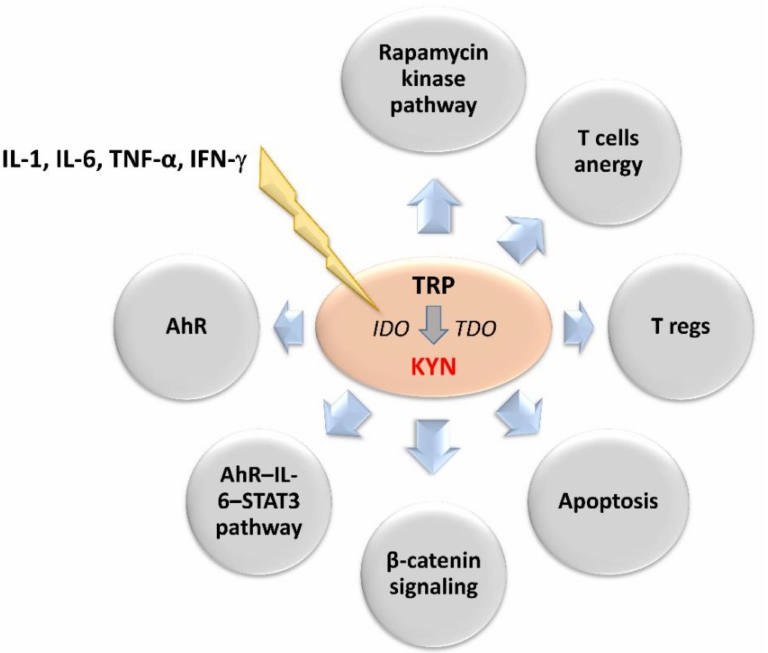
Figure 2. Upstream regulators of 2,3-dioxygenases activity and downstream effectors of kynurenine involved in neoplastic progression. IL-1, IL-6, TNF- α and IFN- γ stimulates IDO leading to enhanced synthesis of kynurenine. Its main effectors are presented in the circles. AhR: aryl hydrocarbon receptor, IDO: indoleamine 2,3-dioxygenase, IFN- γ : interferon- γ , IL-1: interleukin 1, IL-6: interleukin 6, KYN: kynurenine, STAT3: signal transducer and activator of transcription 3, TDO: tryptophan 2,3-dioxygenase, TNF- α : tumor necrosis factor- α , TRP: